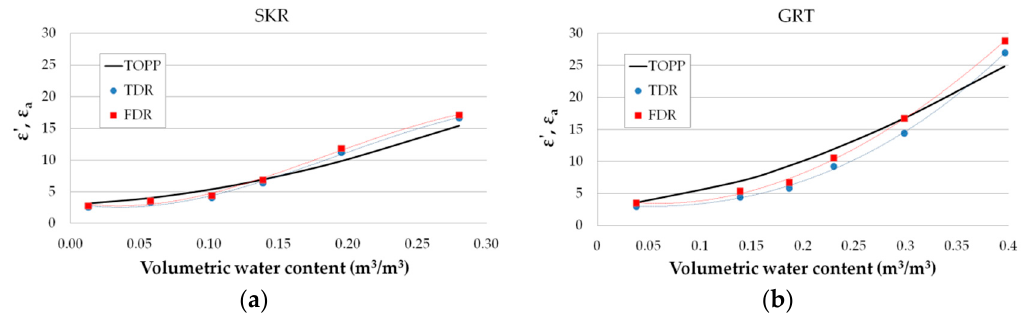
Figure 3. Relations between (cid:2239) (cid:4593) (FDR), (cid:2239) (cid:2183) (TDR—ADS simulation) and volumetric water content for SKR and GRT soils for frequency 200 MHz (FDR) and range of frequency from 1 MHz to 6 GHZ (TDR). Black solid lines correspond to the Topp’s